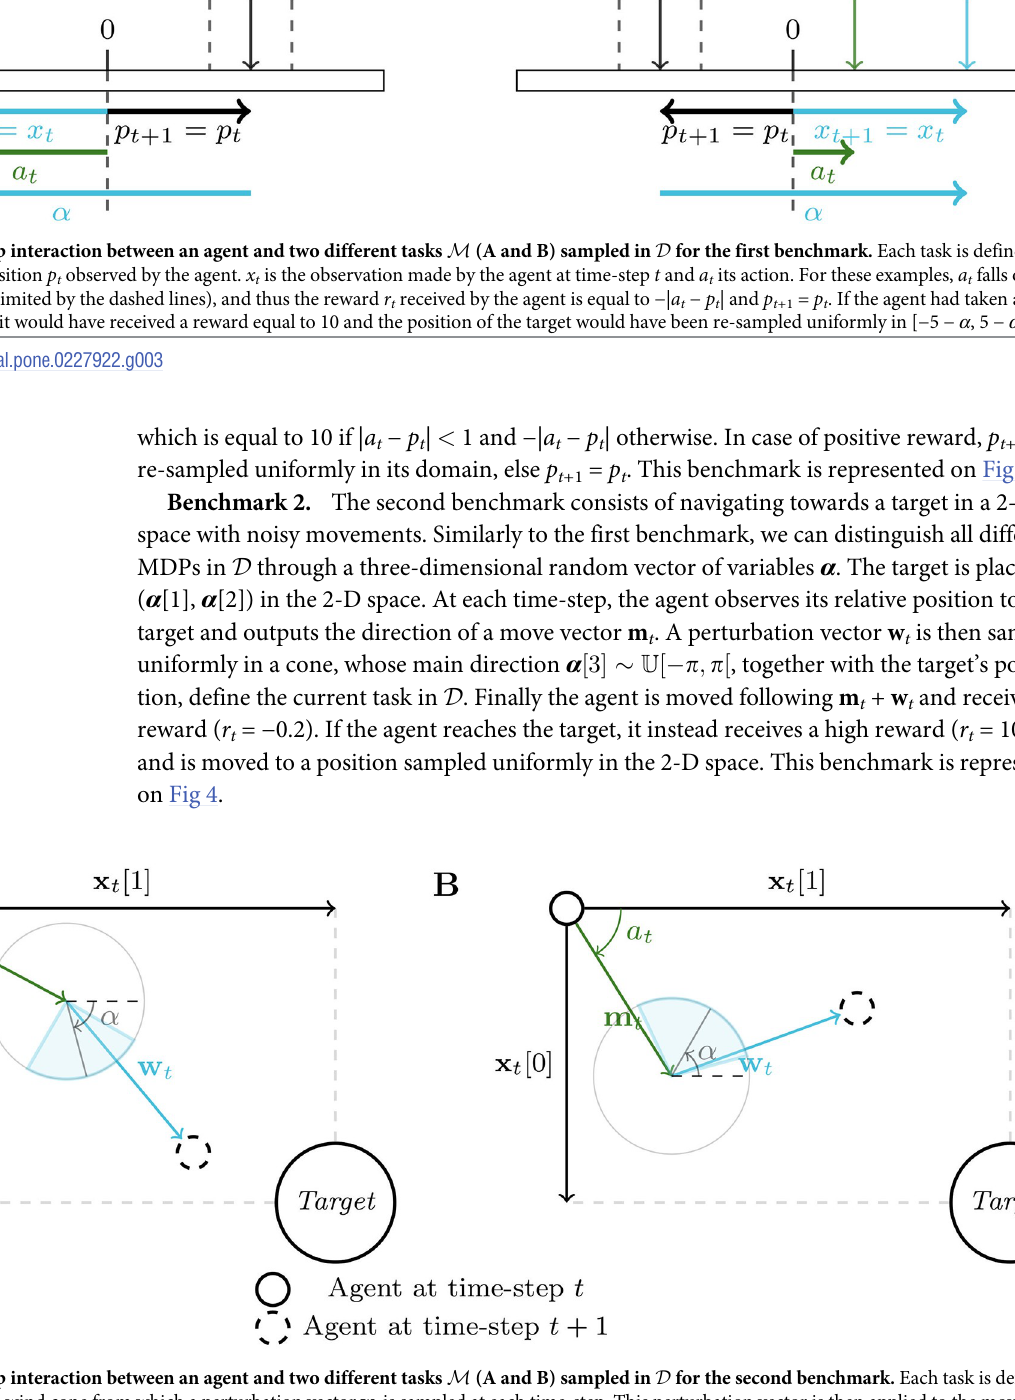
is sampled at each time-step. This perturbation vector is then applied to the movement t